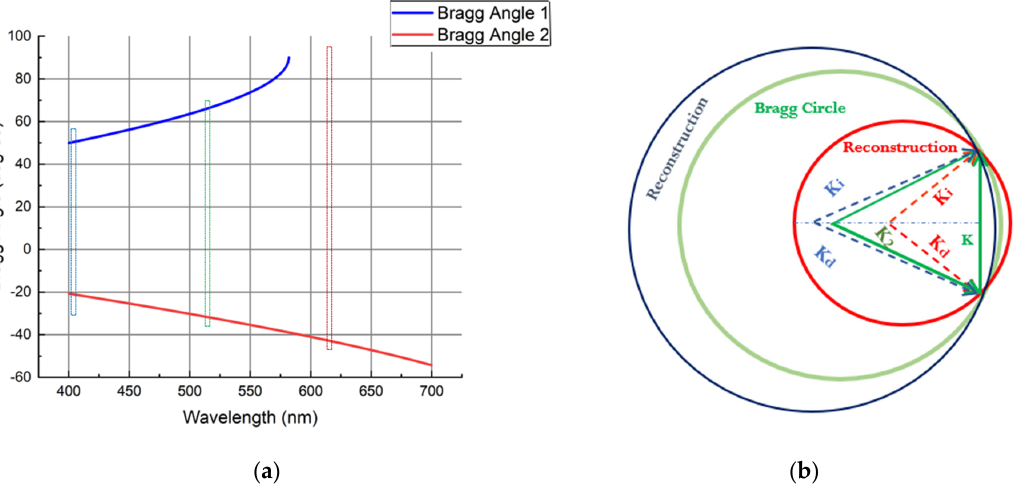
Figure 7. ( a ) Expected incident beam angles for maximum Bragg diffraction as a function of wave- length for the coupler HOE (designed for input angle − 45 ° in air and output angle 45 ° in the medium (633 nm)). ( b ) Bragg circle diagram for the coupler at 633 nm, 532 nm and 405 nm.